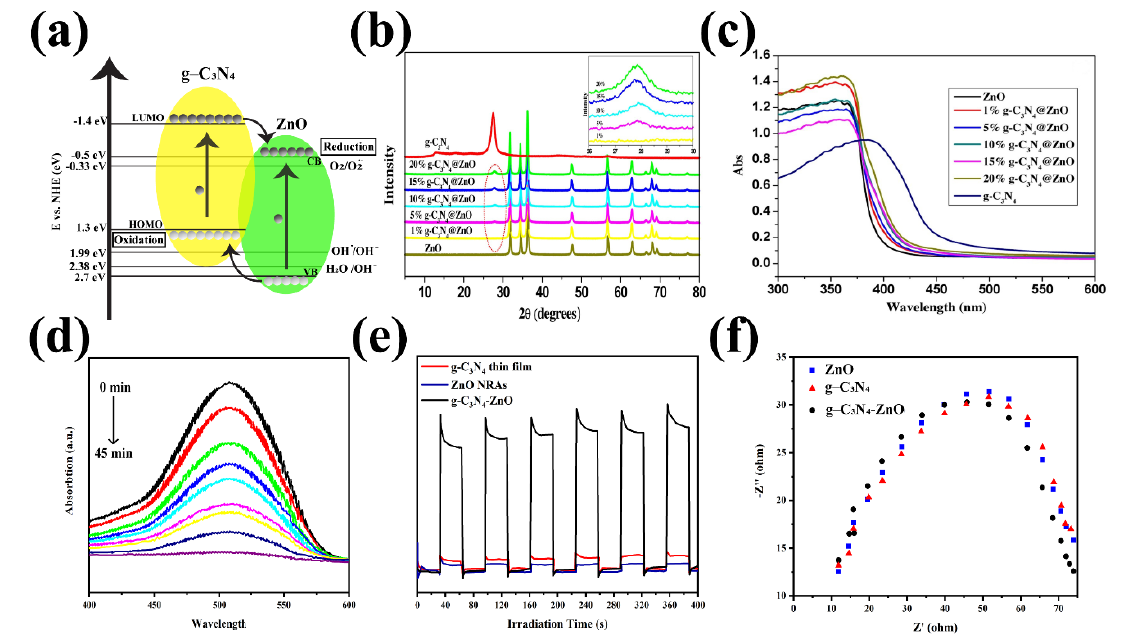
Figure 13. ( a ) Proposed mechanism for charge transfer of type II of the g-C 3 N 4 -ZnO heterojunction interface under visible light irradiation; ( b ) XRD patterns of ZnO, g-C 3 N 4 , and g-C 3 N 4 @ZnO samples; ( c ) UV-vis absorption spectra of ZnO, g-C 3 N 4 , and g-C 3 N 4 @ZnO composites, Copyright © 2022 Elsevier [164]; ( d ) Malachite Green (MG) photocatalytic activity of the g-C 3 N 4 /ZnO photocatalyst, Copyright © 2022 Elsevier [165]; ( e ) the pure ZnO NRAs, g-C 3 N 4 thin film, and g-C 3 N 4 /ZnO heterostructure photocurrent response to a light on-off under visible light illumination (≥ 420 nm), Copyright © 2022 Elsevier [159]; ( f ) Nyquist plots of the ZnO, g-C 3 N 4 , and g-C 3 N 4 /ZnO catalysts. Reproduced from Reference [160].